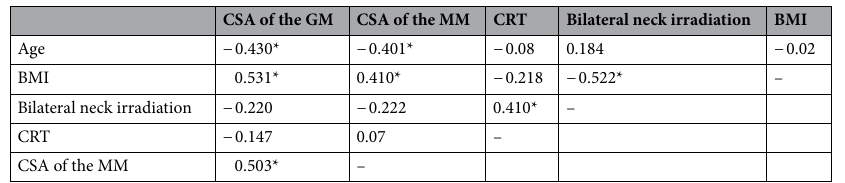
Table 3. Spearman’s rank correlation test results. CSA cross-sectional area, MM masseter muscle, GM geniohyoid muscle, CRT chemoradiotherapy, BMI body mass index. *P <